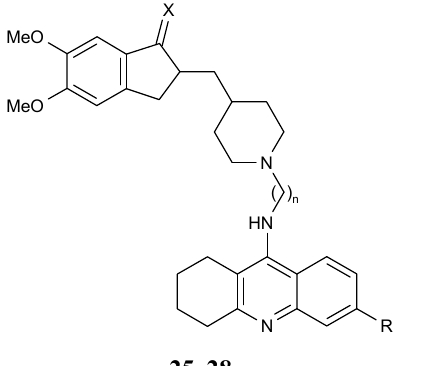
Figure 11. Tacrine-donepezil hybrids 25–28